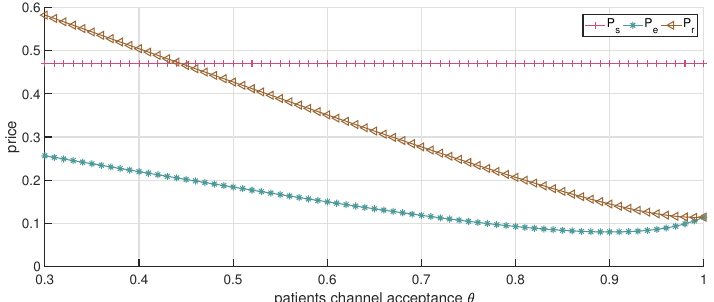
Figure 9. The impact of changes in θ on service price (dual-channel strategy p 0 = 0.8).